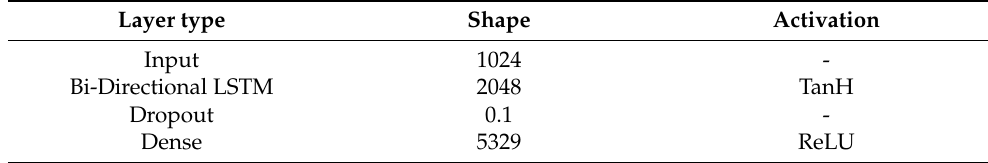
Table 4. The architecture of the LSTM